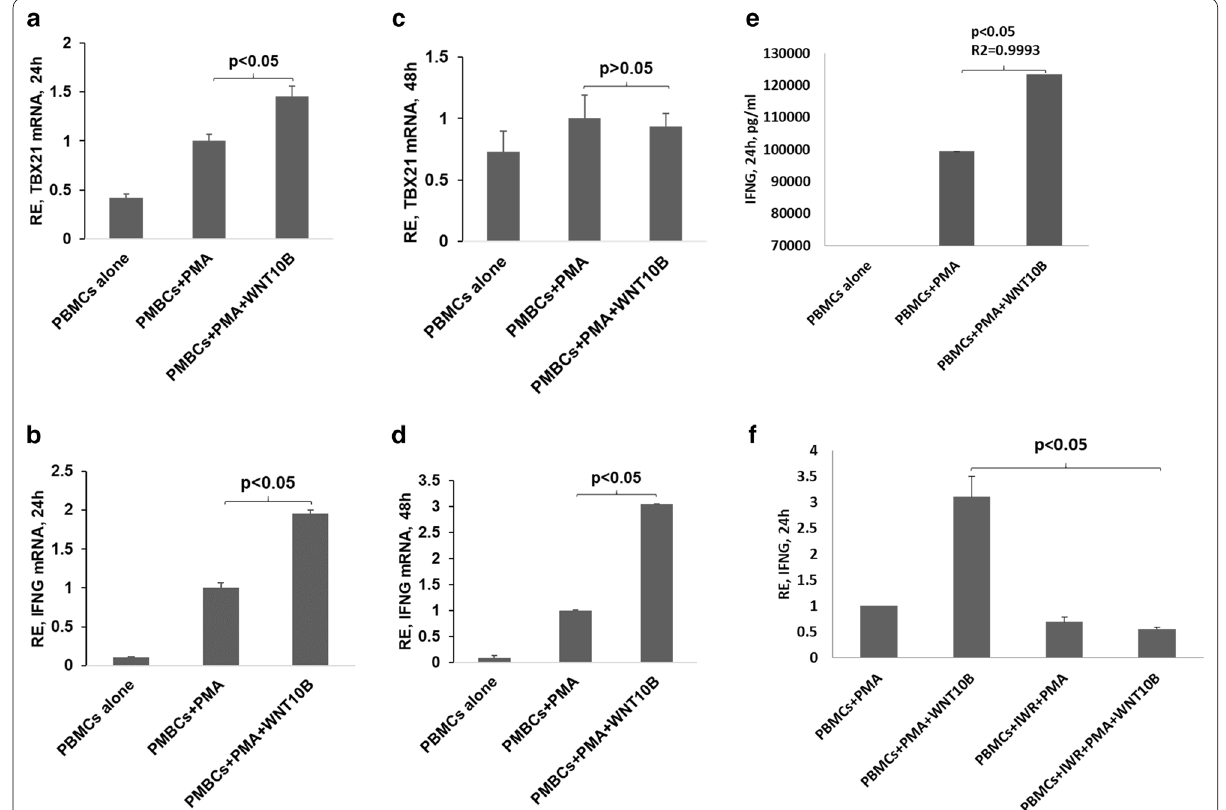
Fig. 4 WNT10B-mediated effect on expression of proinflammatory genes. PBMCs from control individuals were cultured for indicated time with/ without rh-WNT10B (200 ng/ml) after pre-activation of the cells with PMA (200 µM). a – d qRT-PCR results showing expression of Tbx-21 and IFNγ after WNT10B addition compared to activated PBMCs after the indicated time of culture. e IFNγ was measured in the culture supernatants after 24 h of WNT10B addition. f Inflammatory gene expression levels after blocking WNT signaling by IWR1 for the indicated time period. The first vertical bars represent controls against which the experiments were compared for fold change calculation. (IWR: IWR1, WNT signaling